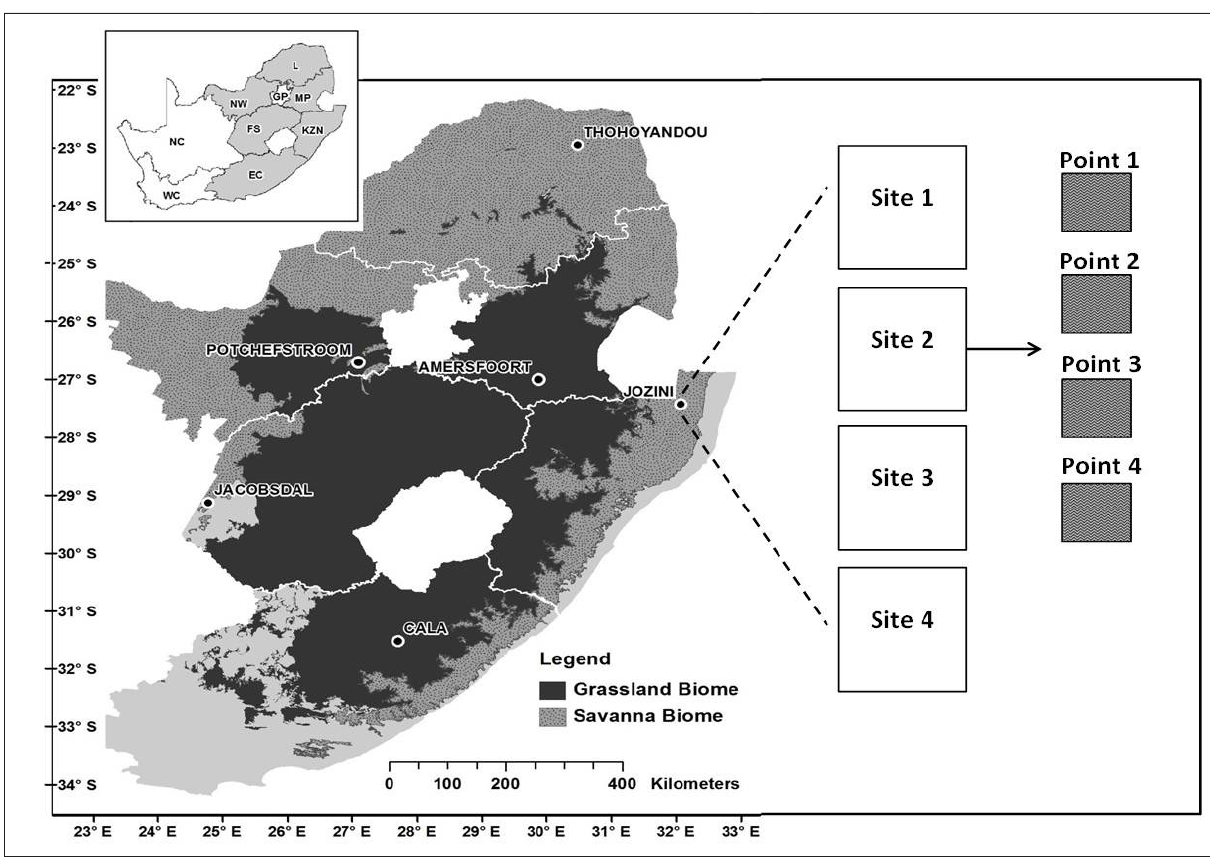
Figure 1: Localities across the six major maize-producing provinces of South Africa within grassland and savanna biomes. EC, Eastern Cape; FS, Free State; KZN, KwaZulu-Natal; L, Limpopo; MP, Mpumalanga; NW, North-West. Three localities were situated in the grassland biome (Amersfoort, Cala and Potchefstroom) and three in the savanna biome (Jacobsdal, Jozini and Thohoyandou). Within each locality, four sites were chosen as indicated. Each site contained four sampling points situated in a crop field margin